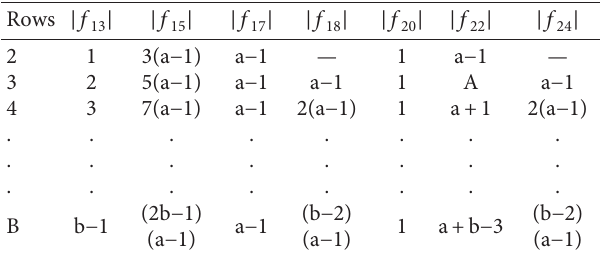
− III [ 5 , 5 ] , respectively. 3 Table 3: Numbers of f number of